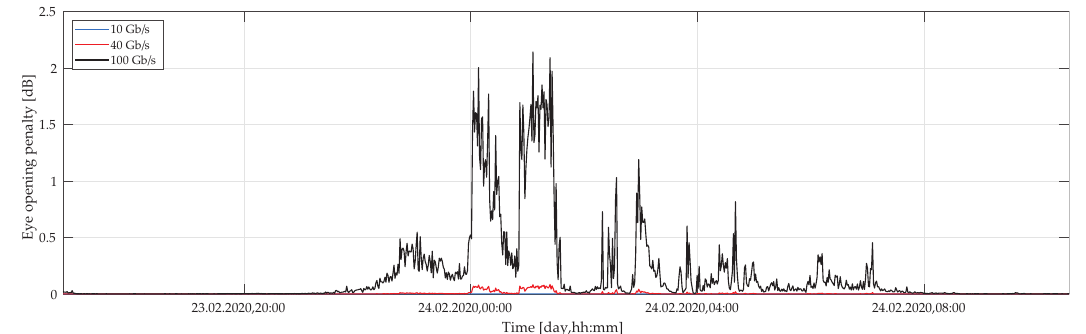
Figure 12. Calculated eye opening penalty as a function of time under strong wind conditions for several transmission bit rates of 10, 40, and 100